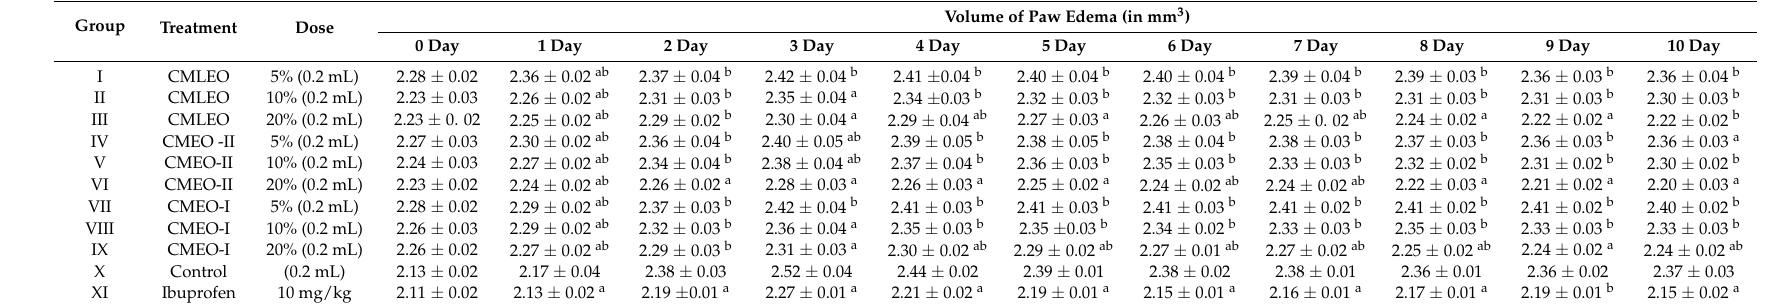
Table 4. Effect of essential oils from C. macrophylla on formalin-induced mice paw